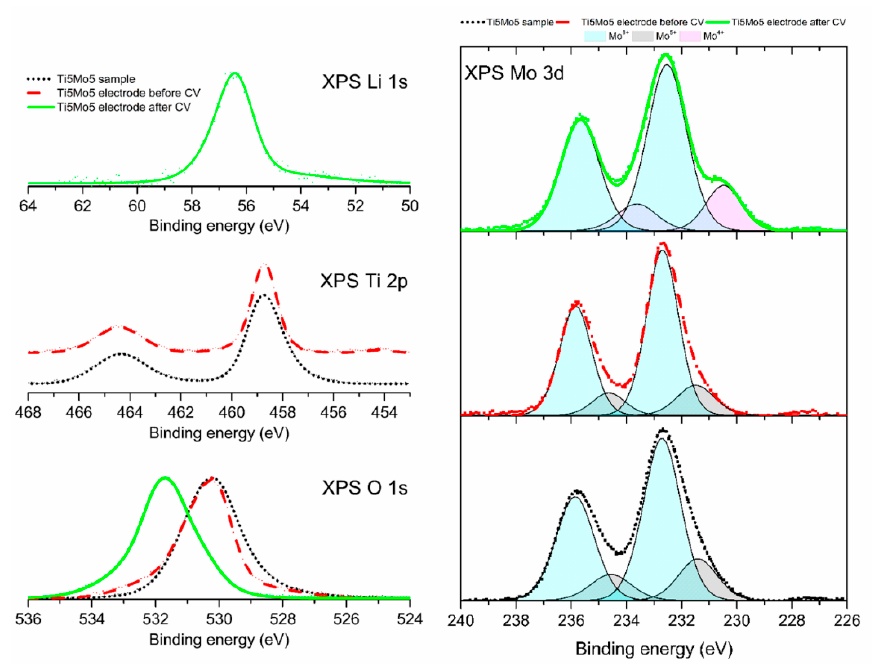
Figure 15. X-ray photoelectron spectra of Li 1s, Ti 2p, O 1s and Mo 3d transitions observed for a Ti5Mo5 sample, the Ti5Mo5 electrode before CV experiments, and the Ti5Mo5 electrode after CV experiments.